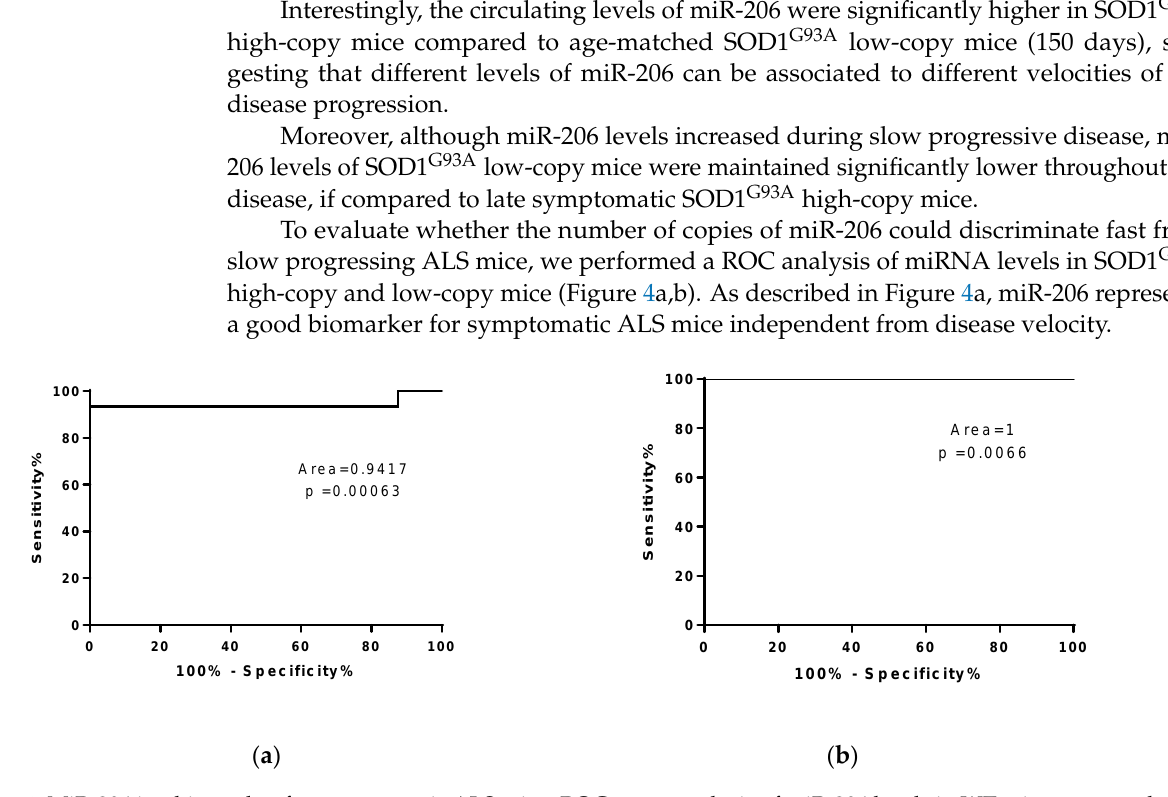
Figure 3. Serum levels of mir-206 are differently modulated during ALS disease progression. Abso- lute quantification of miR-206 levels in SOD1 G93A high-copy and SOD1 G93A low-copy mice at different stages of the disease (* comparison vs. control: ** p < 0.005, *** p < 0.0005. ^ and # comparison between groups: ^^ p < 0.005 # p < 0.05, #### p < 0.0001. •, ▲ , ▼ , , ■ , represent samples of WT control mice, ◆